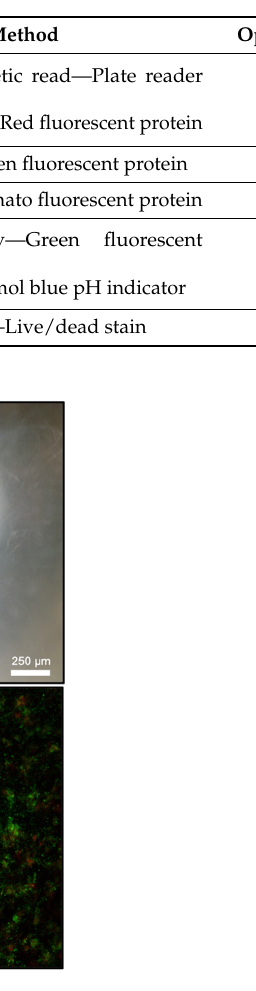
Figure 2. Microbial growth within SSAs. ( A ) Confocal fluorescent microscope image of Escherichia coli ∆ ch1A within an SSA. Bacteria are tagged with red fluorescent protein and can be seen represented in red. The white dashed line shows the upper left boundary of the SSA structure. ( B ) Light microscope image of a SSA printed with Neurospora crassa spores. This image shows hyphae fully colonizing the SSA interior and expanding beyond the structure. ( C ) Confocal fluorescent microscope image of Pseudomonas fluorescens SBW25 at the SSA—media interface. Bacteria are tagged with green fluorescent protein and can be seen represented in green. The white dashed line represents the edge of the SSA, where bacteria to the right of this line are within the SSA. ( D ) Confocal fluorescent image of Paenibacillus polymyxa DSM 36 in an SSA. This strain was visualized using live/dead staining, where live bacteria are represented in green and dead bacteria are represented in red (an alternatively colored image is also available as Figure S2). The white dashed line represents the left boundary of the SSA. All SSAs were surrounded by liquid media during incubation and